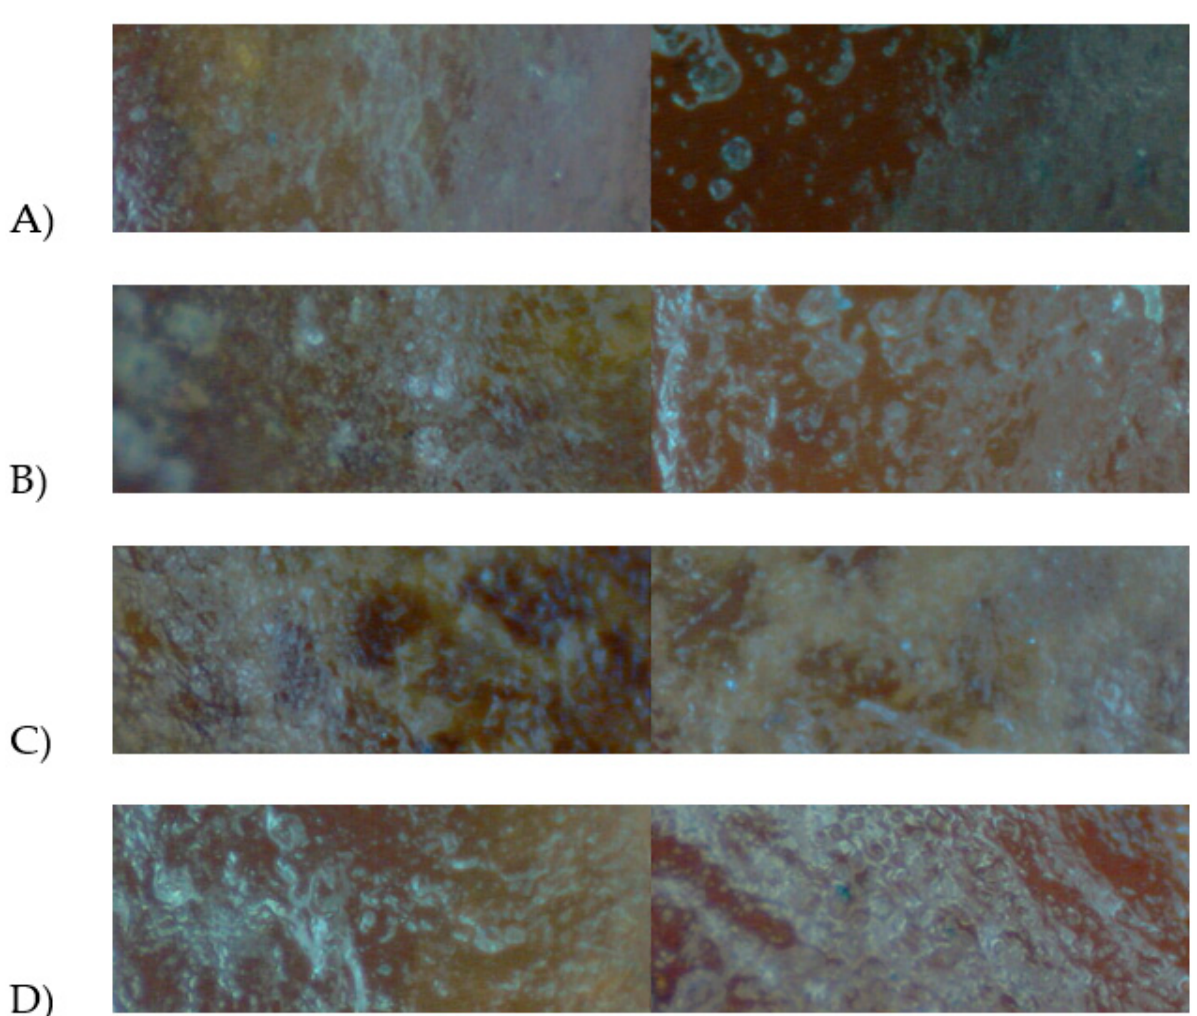
Figure 9. Comparison of date surfaces under various processing conditions with US at 8 MPa: ( A ): 800 W; ( B ): 1.2 kW; ( C ): 1.7 kW; ( D ): no processing.